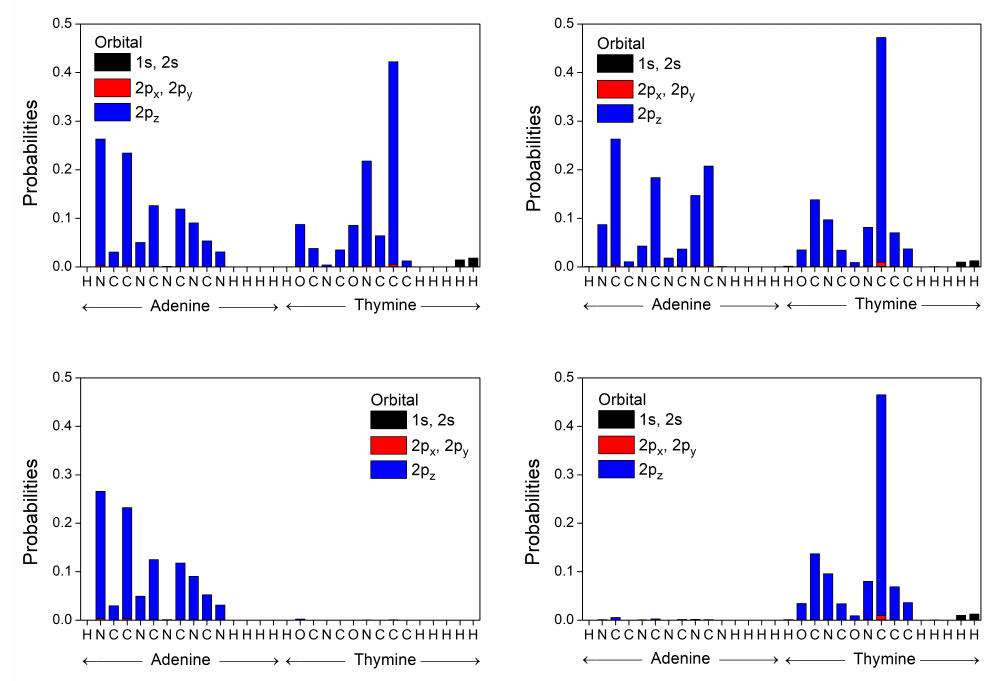
Figure 6. Occupation probabilities of each atomic orbital, | c i ν | 2 (cf. Equation (1)), for the HOMO (left ) and LUMO ( right ) states of A and T bases into an A-T base pair ( top ), along with the corresponding probabilities (cf. Equation (12)) for the HOMO and LUMO states of the A-T base pair ( bottom